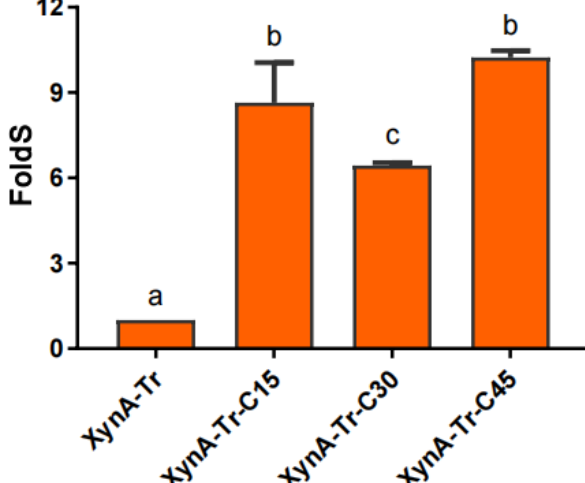
Figure 8. The specific activities of the variants. Results are expressed as means of three replicates and standard errors. Means with different letters are significantly different according to t -tests ( p < 0.05).